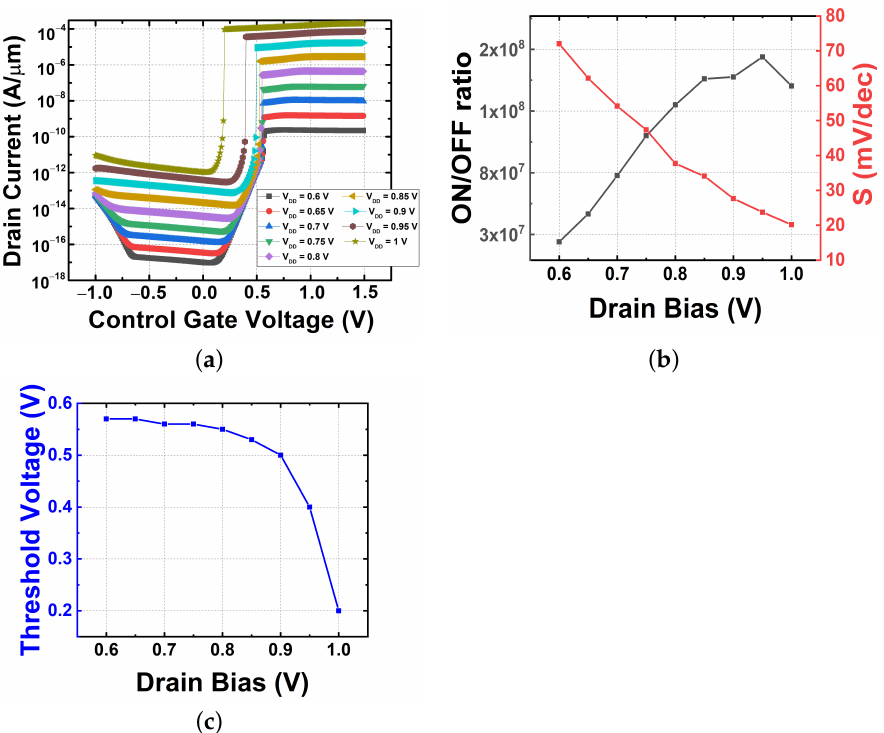
Figure 3. Electrical characteristics with drain voltage variations. ( a ) Transfer characteristics, ( b ) on–off current ratio and subthreshold swing, and ( c ) threshold